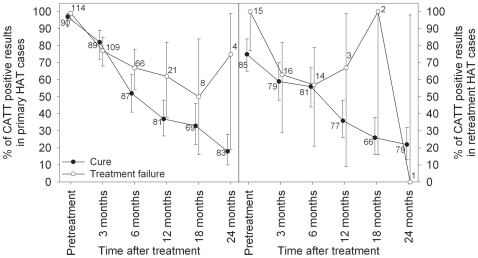
CATT positivity (%) during follow-up in primary HAT (left) and retreatment cases (right) who were cured or experienced treatment failure after current treatment.The number of samples that was tested is indicated, whiskers show 95% confidence intervals.